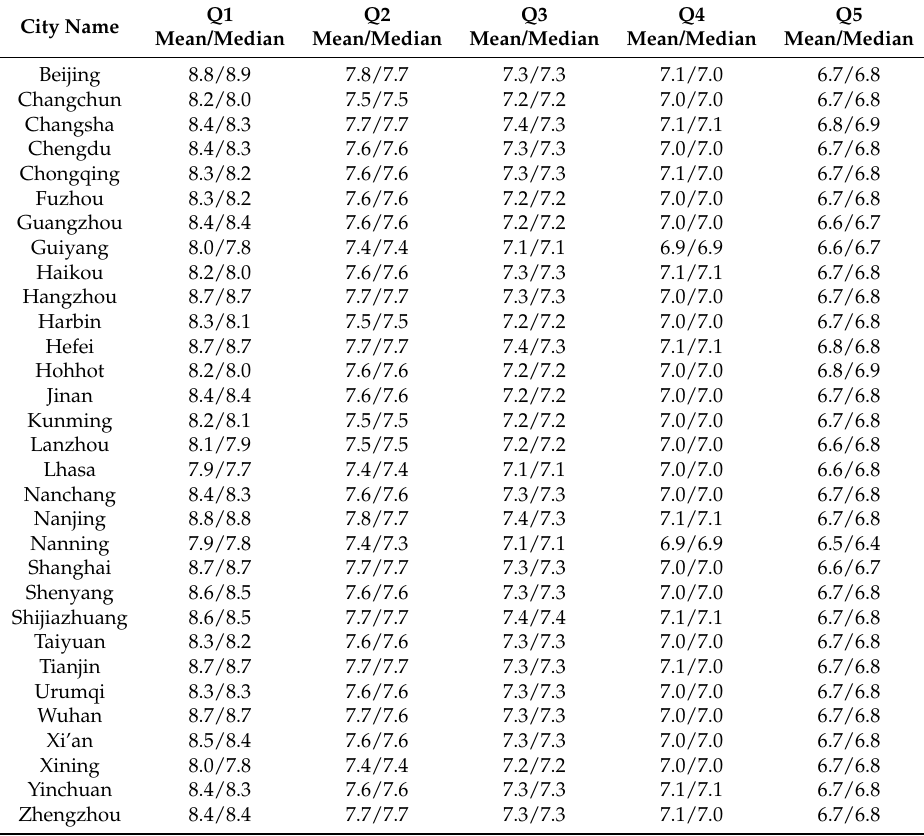
Table A3. Mean and median values of T (ratings of taste) of restaurants. For each city, the restaurants are sorted by T and divided into five quantiles, with each quantile accounting for 20 percent of all the